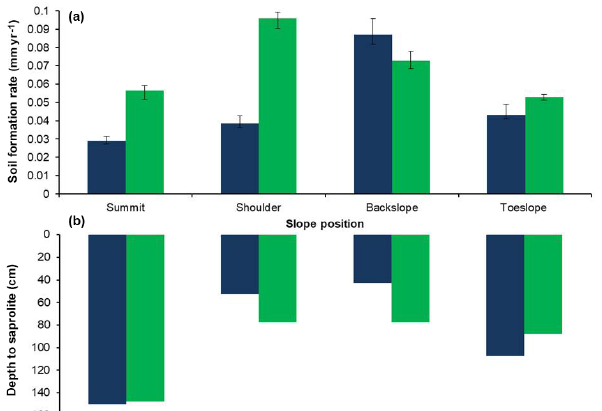
Figure 2. Soil formation rates and the depths to saprolite for the four sampling positions along the catena transects at Rufford Forest Farm (blue; n = 4) and Comer Wood (green; n = 4). The error bars represent 1 σ uncertainties. At RFF, two 10 Be concentrations down the same depth profile have been used in the coSOILcal model to derive a “best fit” soil formation rate. Depth here refers to that for the midpoint (between the top and bottom) of the